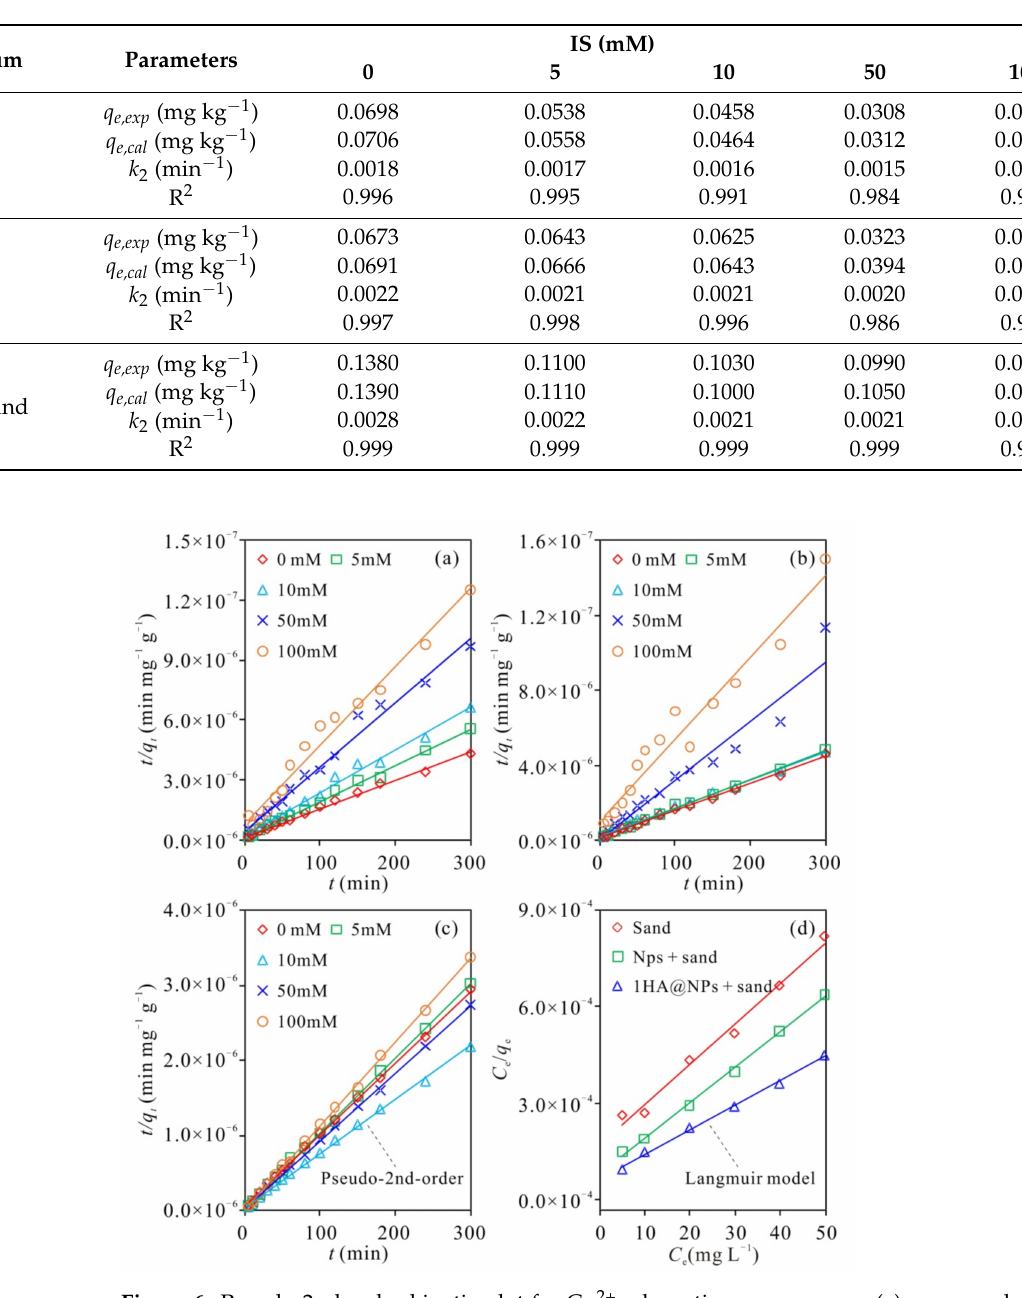
Table 2. Fitted parameters of the adsorption kinetics models for the adsorption of Cu 2+ in different media, with the IS of 0–100 mM.